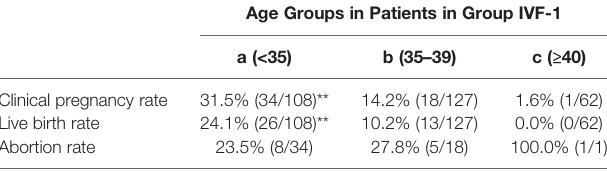
TABLE 6 | Clinical pregnancy and live birth rates in patients in Group IVF-1 classi fi ed into three groups by age at initiation of follow-up.